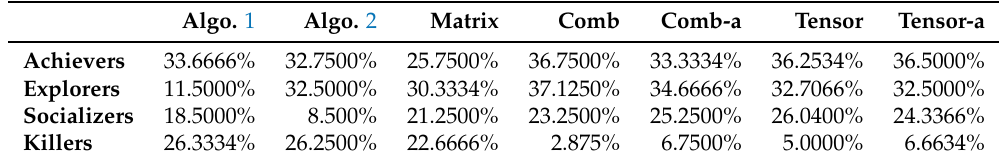
Table 13. Player type distributions (Source: